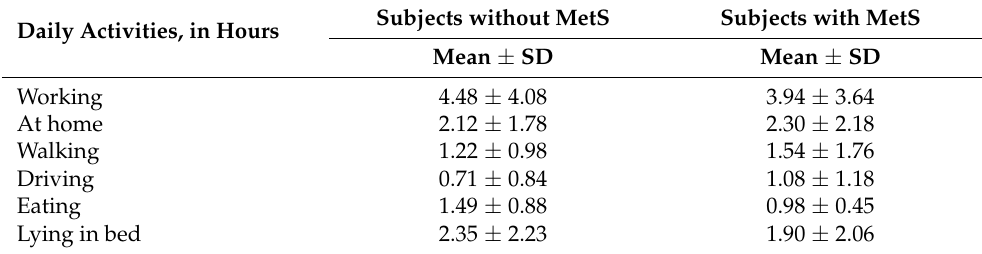
Table A1. Daily activities according to the data from the subjects’ diary. Daily Activities, in